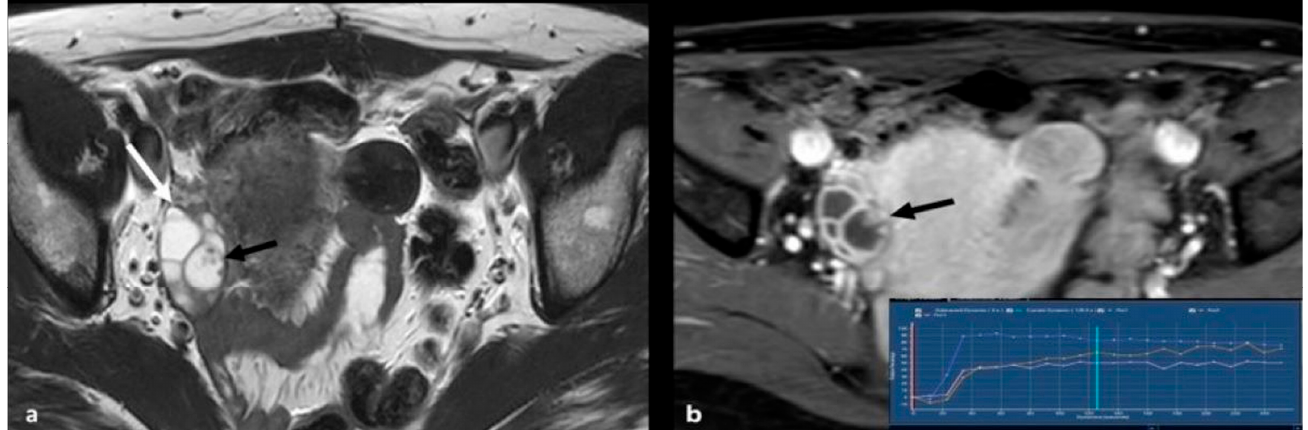
Figure 5. Serous epithelial borderline ovarian tumor. Axial T2 weighted image ( a ) shows a multiloculated cystic lesion at the right ovary (white arrow). A small, papillary projection (black arrow) is present, with avid enhancement on the T1 weighted FS CE image (( b ), black arrow). An intermediate-risk time intensity curve (TIC type 2) was detected on DCE image analysis (inset in b, blue line: myometrium, orange/pink lines: papillary projection).